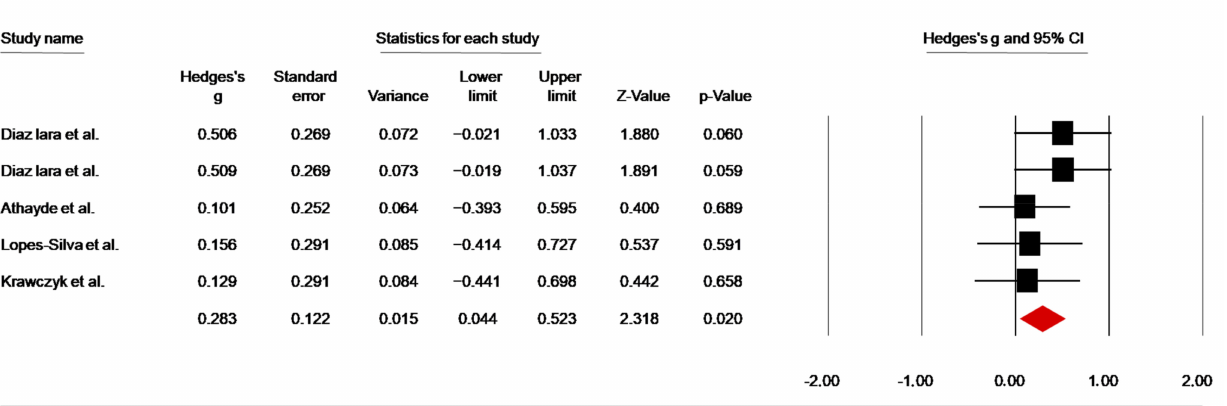
Figure 3. Forest plot of the total effect size of caffeine intake on handgrip strength [46,48,49,53,59].